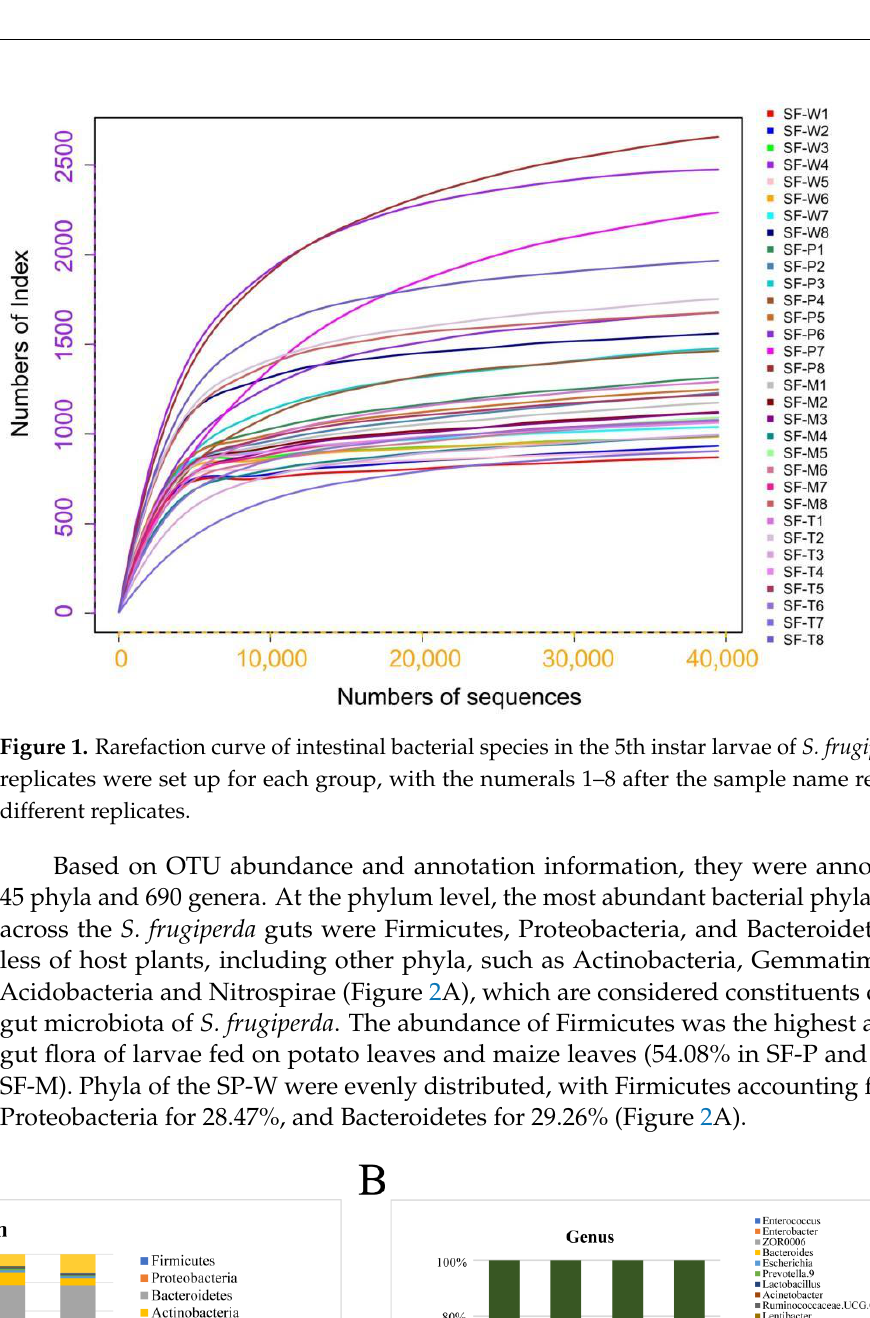
Insects 2022 , 13 , x FOR PEER REVIEW 5 of 14 Table 1. Statistics of effective sequencing data of bacterial 16S rRNA in the larval S. frugiperda. Sample